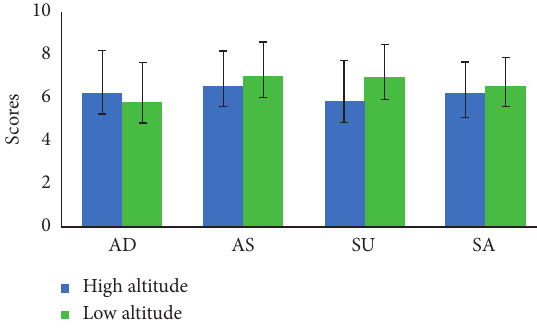
Figure 2: Scores of situation awareness. Table 3: Results of internal consistency and validity of factors.